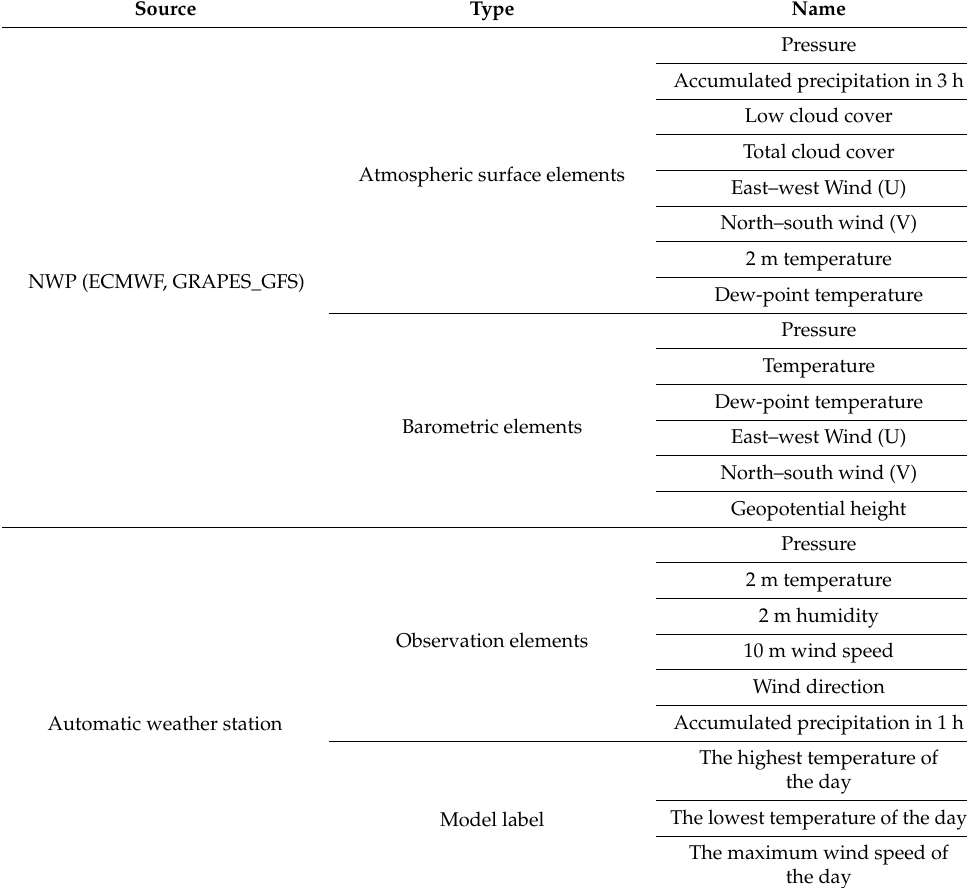
Table 1. ML-MOS model input